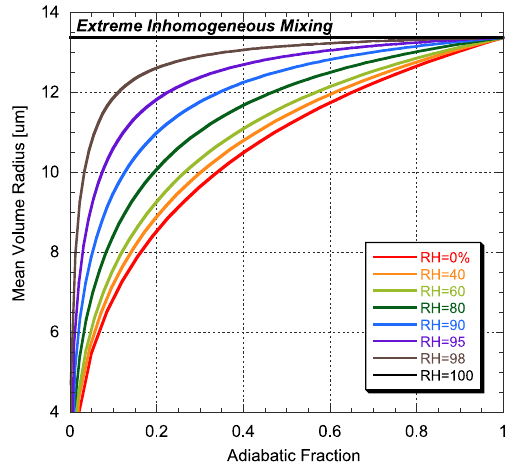
Fig. 1. Mixing diagram: the relationship between the droplet mean volume radius ( R v ) and the adiabatic fraction (AF) for fully ho- mogeneous and extreme inhomogeneous mixing events between an adiabatic cloud parcel and entrained non-cloudy air with vary- ing relative humidity (RH) at the mixing level of ∼ 2200m above cloud base, where the temperature of the cloudy and entrained air is ∼ 10 ◦ C and the adiabatic liquid water mixing ratio is 5gkg − 1 . The cloud base is at 850hPa and 20 ◦ C. The concentration of the activated CCN ( N a ) is 500mg − 1 . It can be seen that entrained air with higher RH results in a smaller dependence of R v on AF, espe- cially for AF > 0.2. When entrained air is saturated (RH=100%), or when mixing is extremely inhomogeneous, R v remains